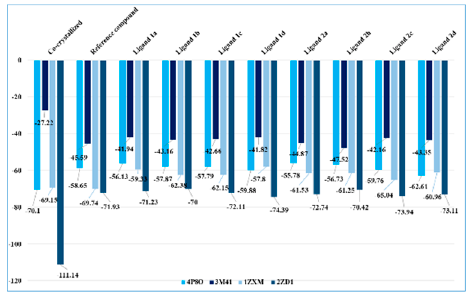
Figure 1. Docking score of quinolone